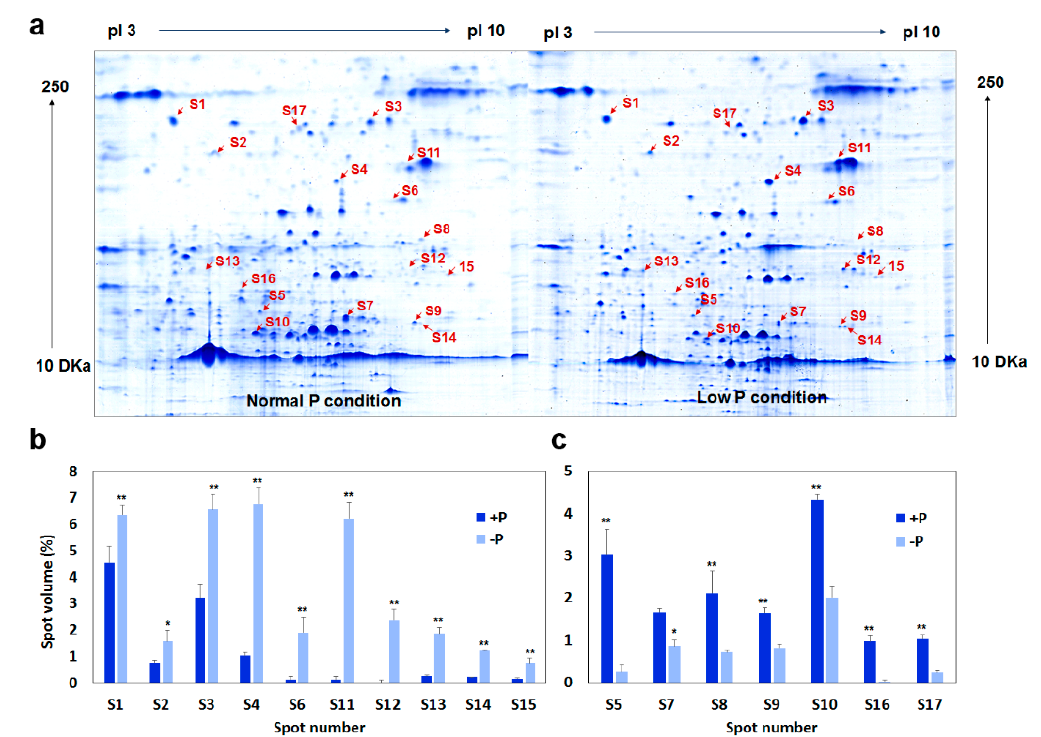
FC: fold change (the relative protein spot volume of − P treatment to the relative protein spot volume of optimum P treatment). The proteins were identified by peptide mass fingerprinting (PMF) and BLASTed in Phytozome and